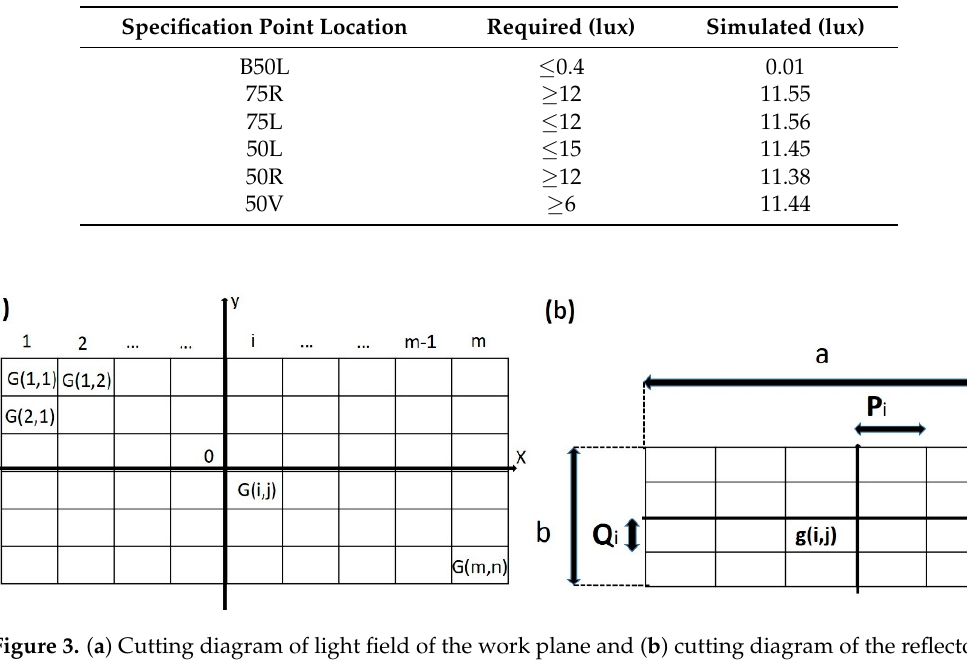
Table 1. Comparison of simulated results at the illumination point of the low beam field with relevant regulations (B50L, 75R, 75L, 50L, 50R, and 50V represent different positions in the illumination area, as shown in ECE R112).